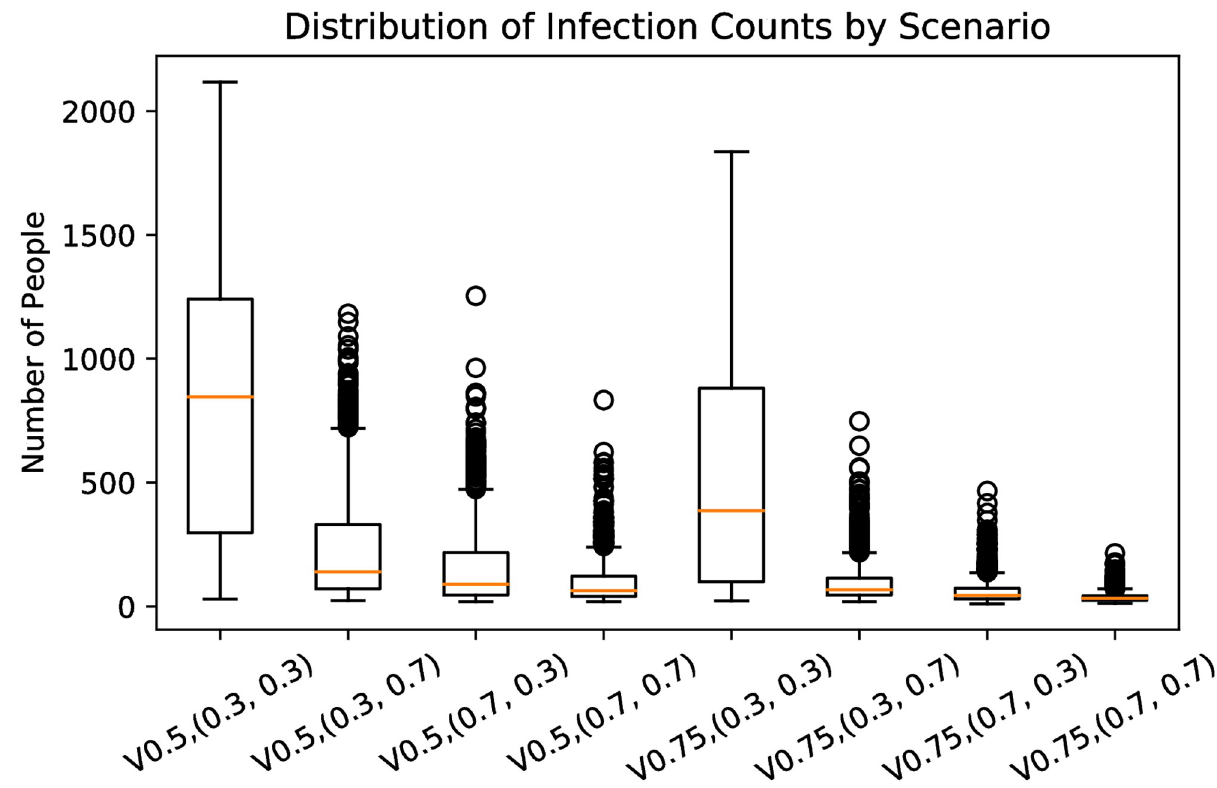
Fig 6. Total infections in the base model with different combinations of r